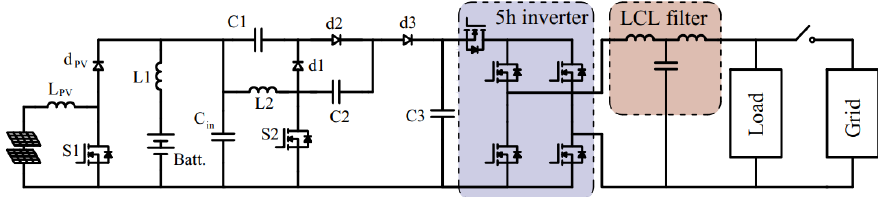
Figure 2. The proposed TPC